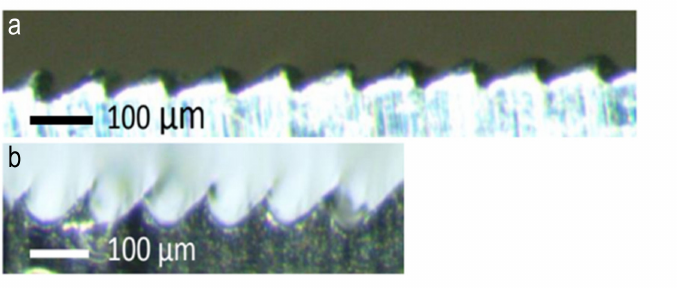
Figure 3. Micrograph of machined Al 7075-T6 ( a ) and AISI 4140 steel ( b